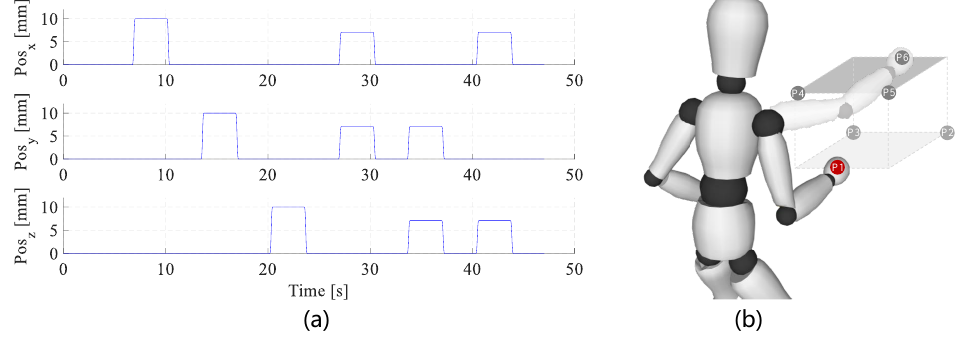
Figure 4. Experimental protocols. ( a ) A typical perturbation trajectory profile with the desired displacement of 10 mm in the target directions ( x , y , z , x − y , y − z , x − z ). ( b ) Predefined equilibrium positions for the perturbation experiments. These positions were selected in two planes, from P1 to P6. In each plane, there were three positions that formed a